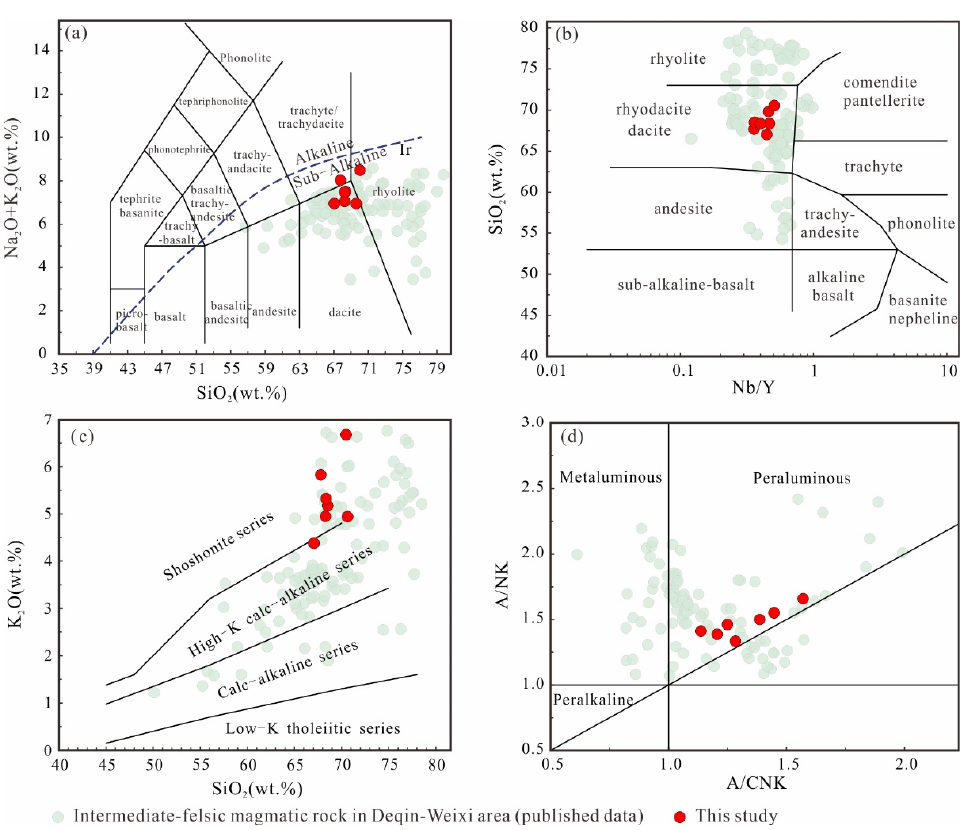
Figure 6. Geological discrimination plots for Deqin–Weixi intermediate-felsic magmatic rocks: ( a ) total alkali-silica (TAS) [39]; ( b ) Nb/Y-SiO 2 [40]; ( c ) SiO 2 -K 2 O [41]; ( d ) A/CNK-A/NK [42]. Data source: [8,10–12,15,43].